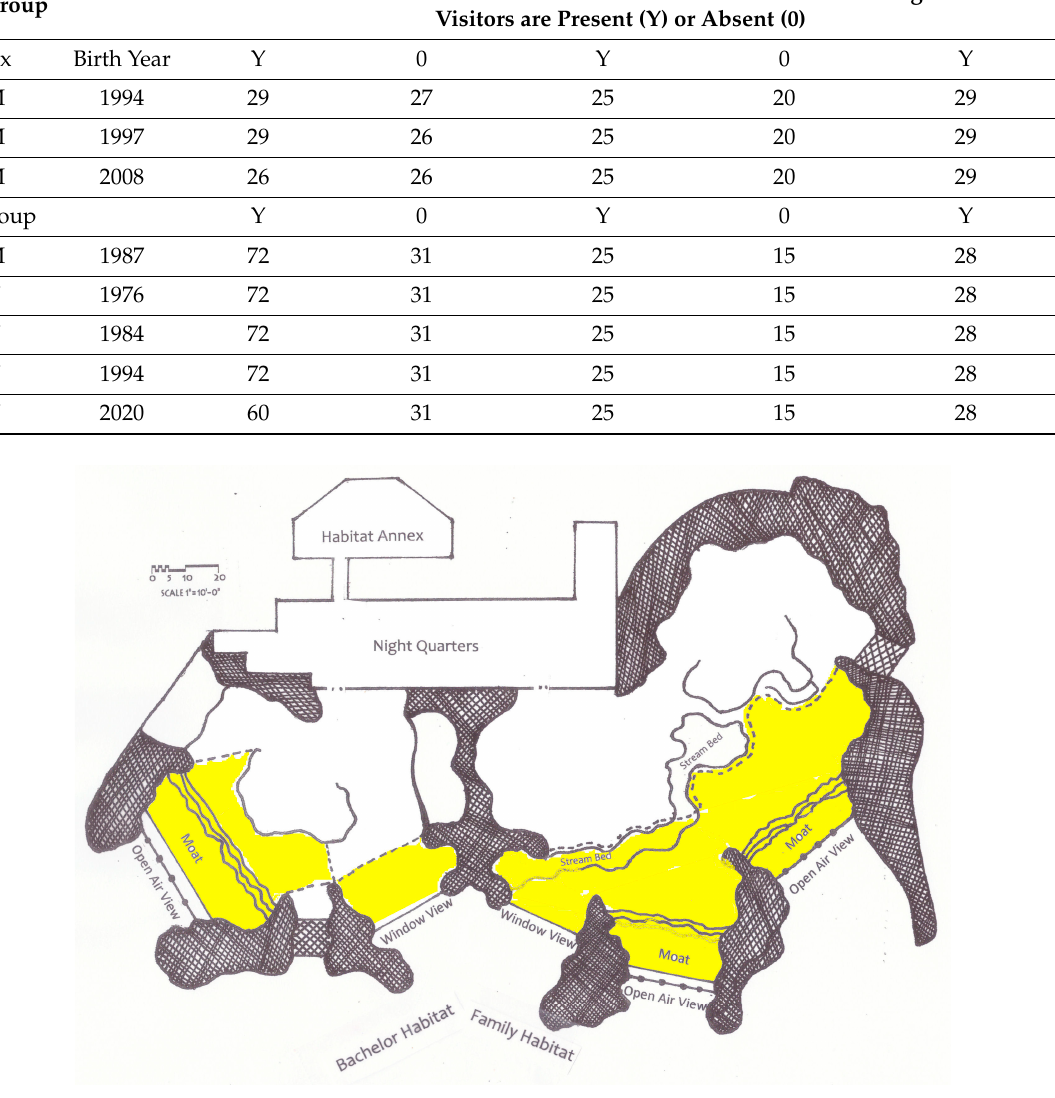
Figure 1. Gorilla outdoor habitat, night-quarters, and off-exhibit outdoor habitat annex. Dark cross- hatching indicates physical and visual barriers. Yellow areas represent habitat sectors within 40 feet of visitor viewing areas.